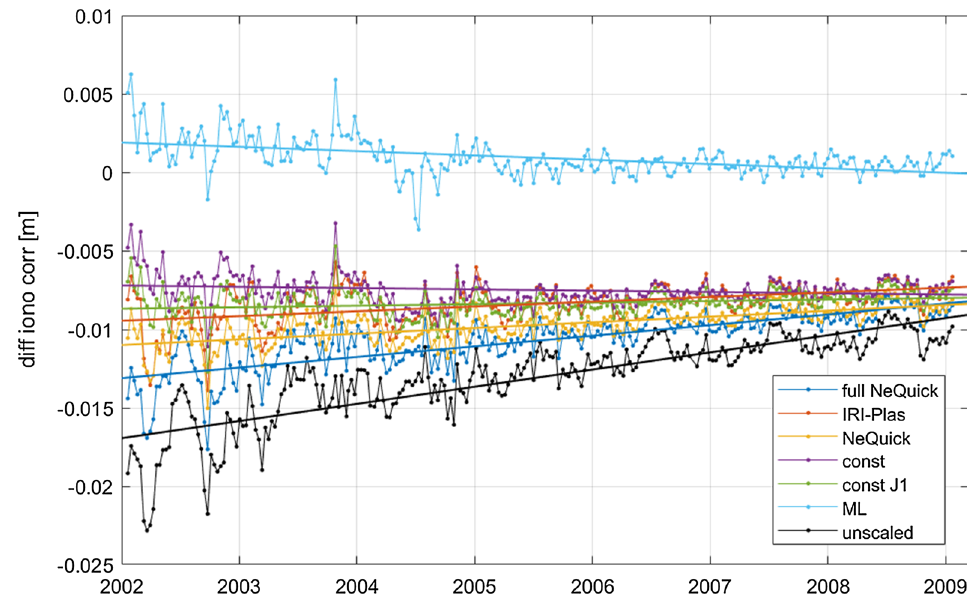
Fig. 6 Trend differences to smoothed dual-frequency altimeter for different scaling solutions